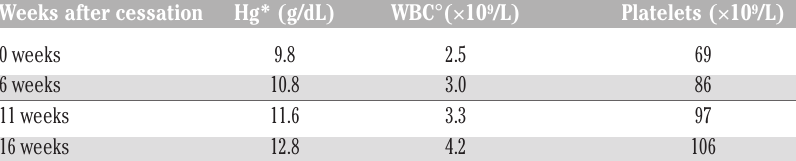
Table 1. Timeline of complete blood count recovery following cessation of amiodarone.